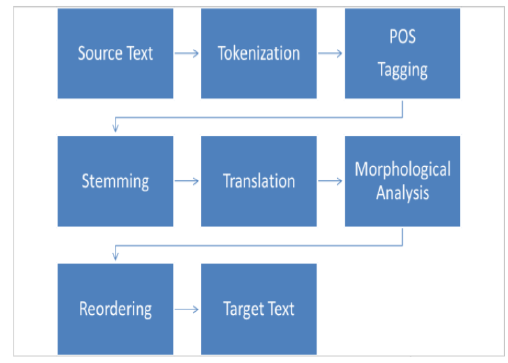
Figure 1. System Design of Rule Based Machine Translation